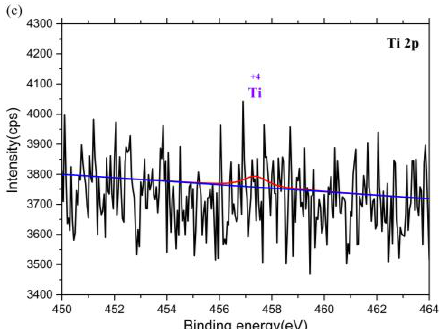
Figure 8. Multiple graphs of the X-ray photoelectron spectroscopy spectra of the three dominant elements coupon exposed to SRB culture. ( a ) sulfur, ( b ) aluminum, and ( c ) titanium.